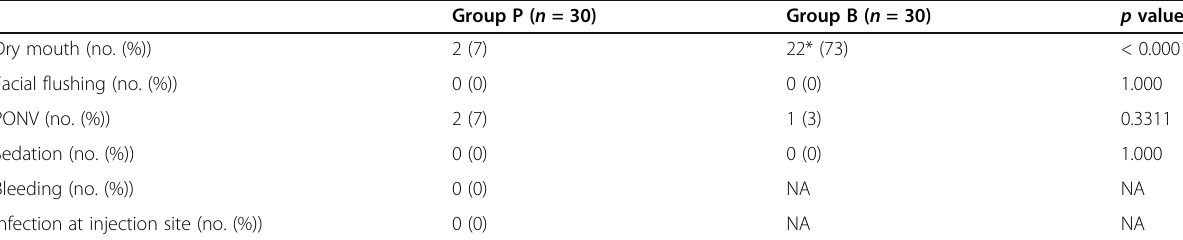
Table 3 Adverse